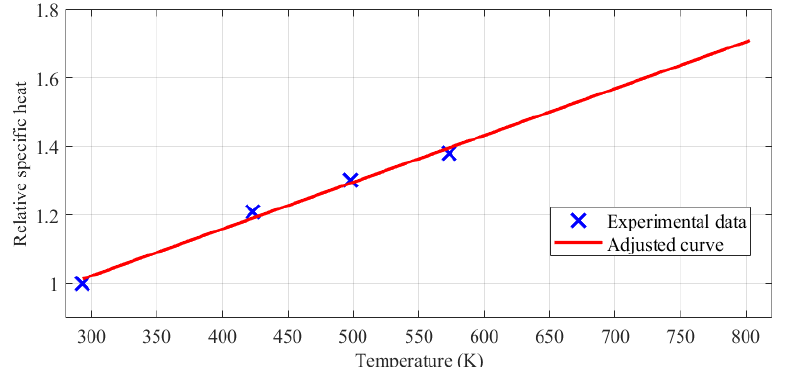
Figure 8. Relation between concrete relative specific heat and temperature.